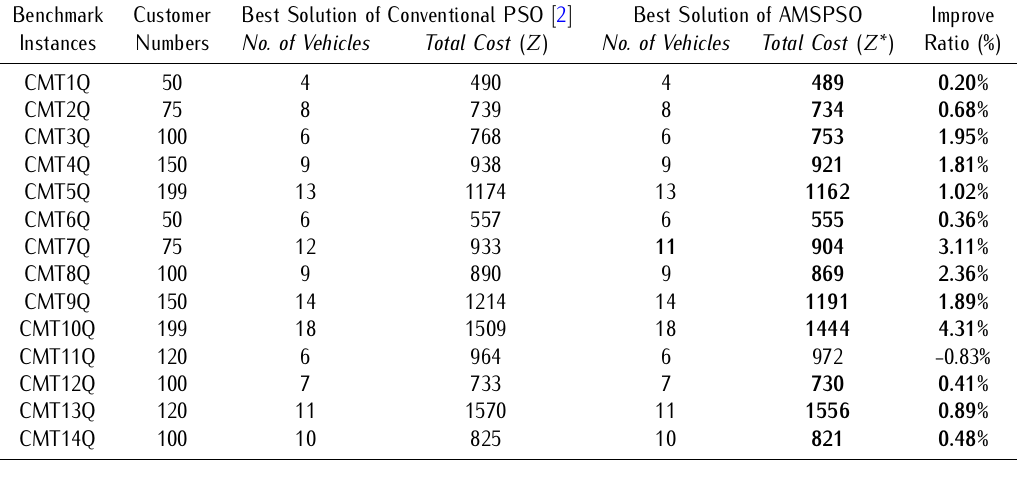
Table 5. Simulation results of CMT n